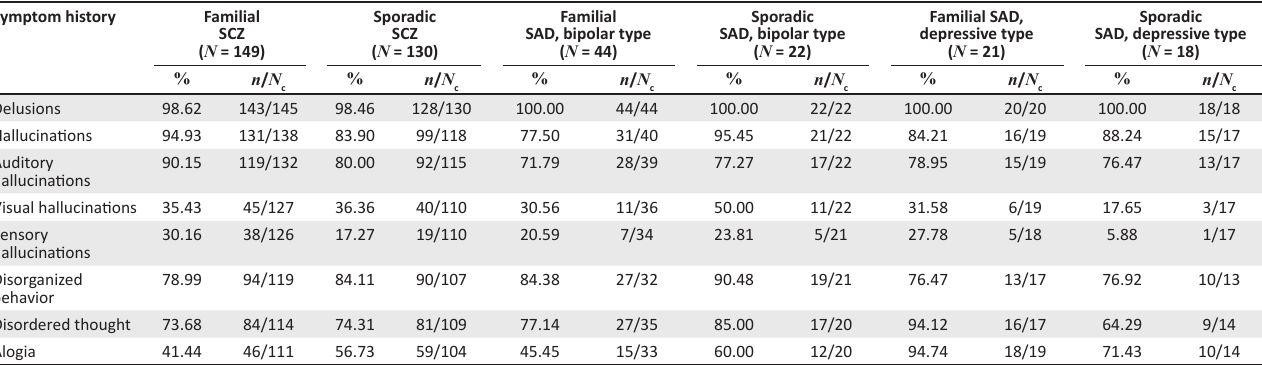
TABLE 1g: Demographic & clinical characteristics of 214 familial and 170 sporadic participants with a DSM diagnosis of schizophrenia or schizoaffective disorder. Symptom history